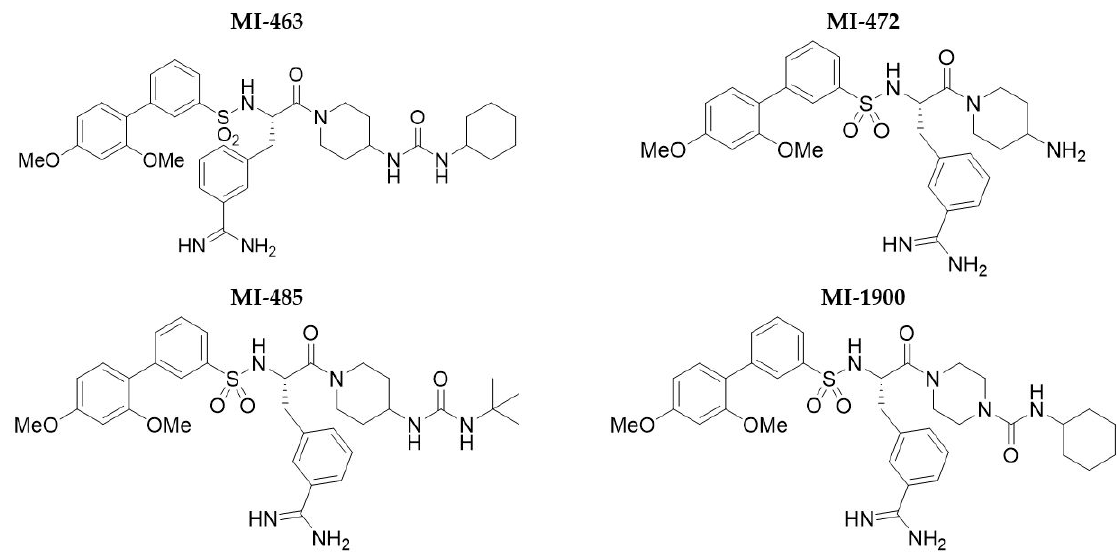
Figure 1. Structures of the matriptase/TMPRSS2 inhibitors applied in this